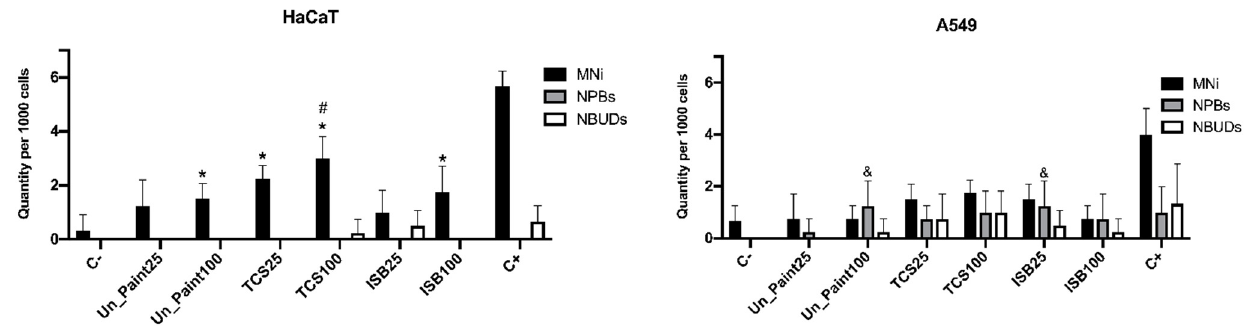
Figure 8. Micronuclei (MNi), nuclear buds (NBUDs) and nucleoplasmic bridges (NPBs) score on HaCaT ( left ) and A549 ( right ) cell lines, after exposure to extracts of the samples (in the x axis) Un_Paint, TCS or ISB extracts for 24 h. C- negative control (complete medium), C+ positive control (MMS 800 µM solution). The values are expressed as mean ± standard deviation. The statistical significance of samples compared to C- is represented by * (Two-way ANOVA; p < 0.05). The statistical significance of samples compared to Un_Paint is represented by # (Two-way ANOVA; p < 0.05). The statistical significance of the extract on A549 cells compared to the same extract, in the same concentration, on HaCaT cells is represented by & (Two-way ANOVA; p < 0.05).